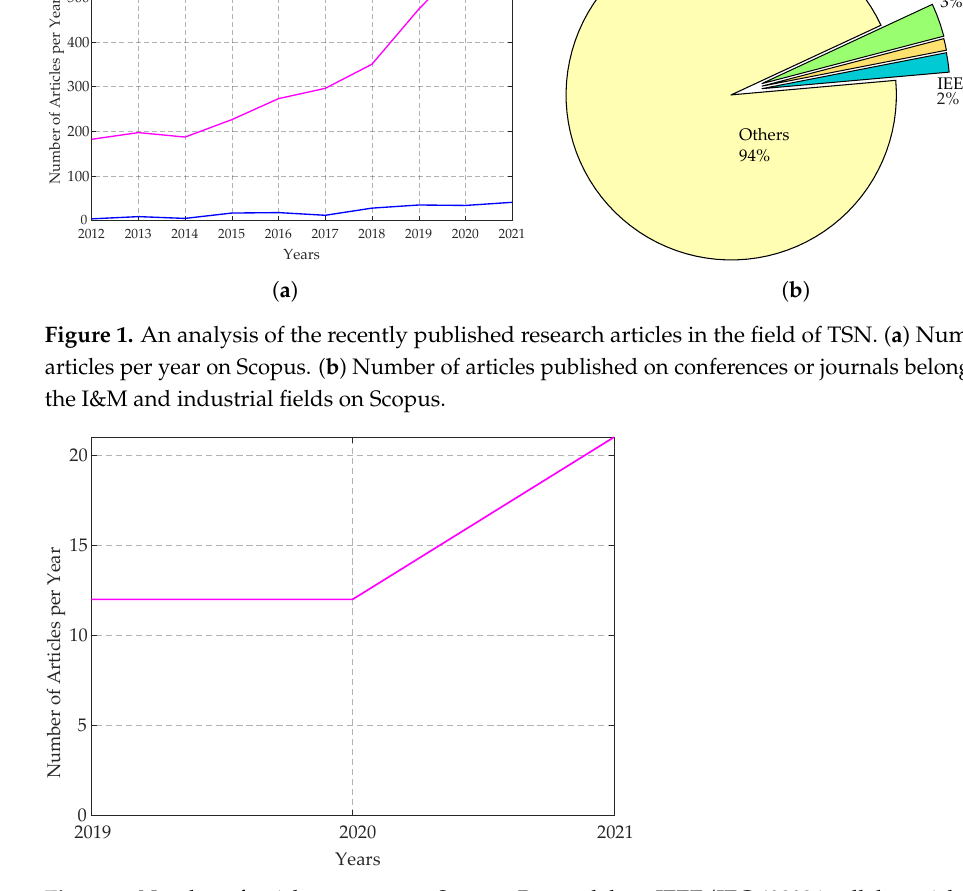
Figure 2. Number of articles per year on Scopus. Research key: IEEE/IEC 60802 in all the article